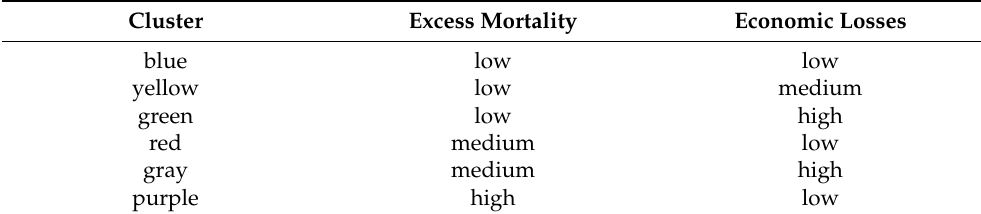
Table 2. Cluster names, health and economic outcomes. Cluster Excess